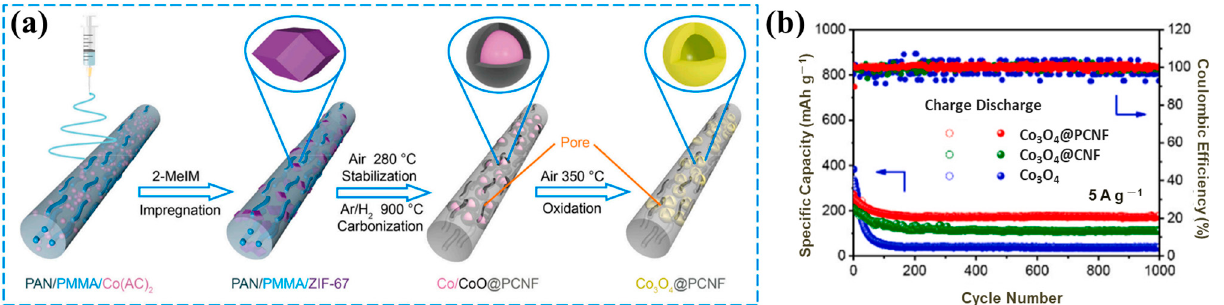
Figure 10. ( a ) Schematic illustration of the production of Co 3 O 4 @PCNF nanofibers; ( b ) cyclic per- formance of Co 3 O 4 @PCNF, Co 3 O 4 @CNF, and Co 3 O 4 . Reprinted with permission from Ref.